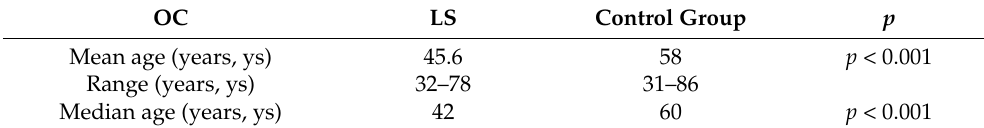
Table 5. Age at diagnosis of Ovaraian Cancer for Lynch Syndrome patients and the control group.